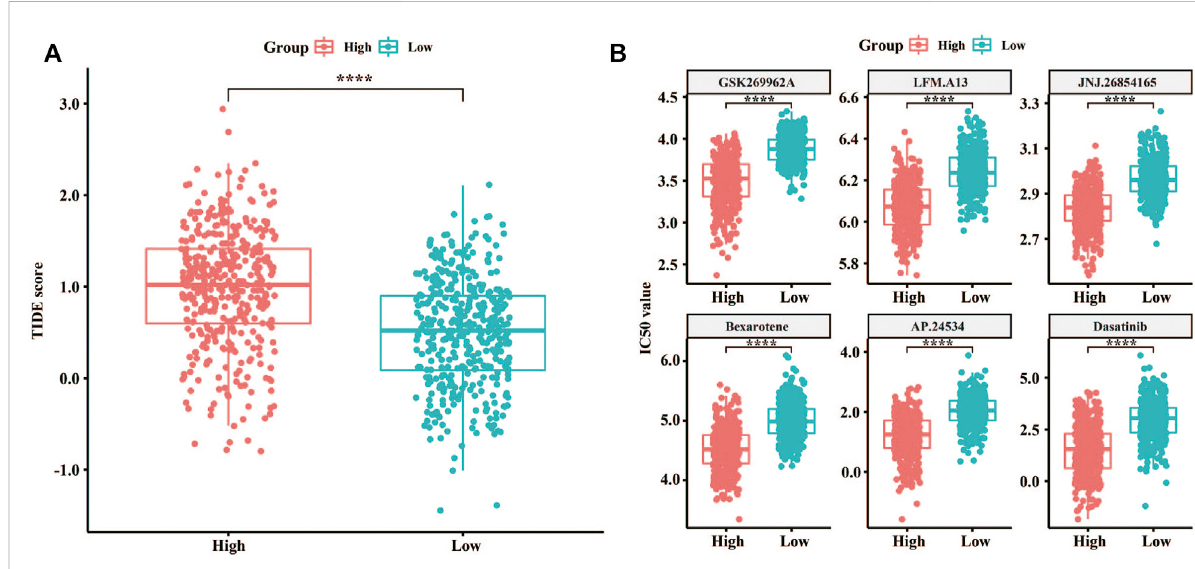
FIGURE 3 Predictive value of the LMscore as a biomarker for immunotherapy and chemotherapy for GC. (A) Box plots showing TIDE scores between the high and low LMscore groups. (B) Boxplots showing theIC50 valuesbetween thehigh and low LMscore groups strati fi edby thedrug, GSK269962A, and LFM. A13, JNJ.26854165, Bexarotene, AP.24534, and Dasatinib. ****, p < 2.22e-16.